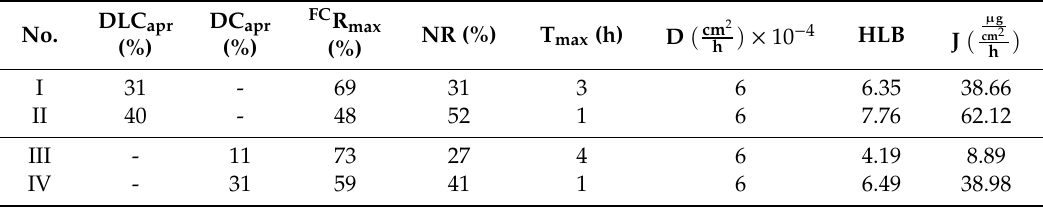
Table 3. Data for permeation tests.